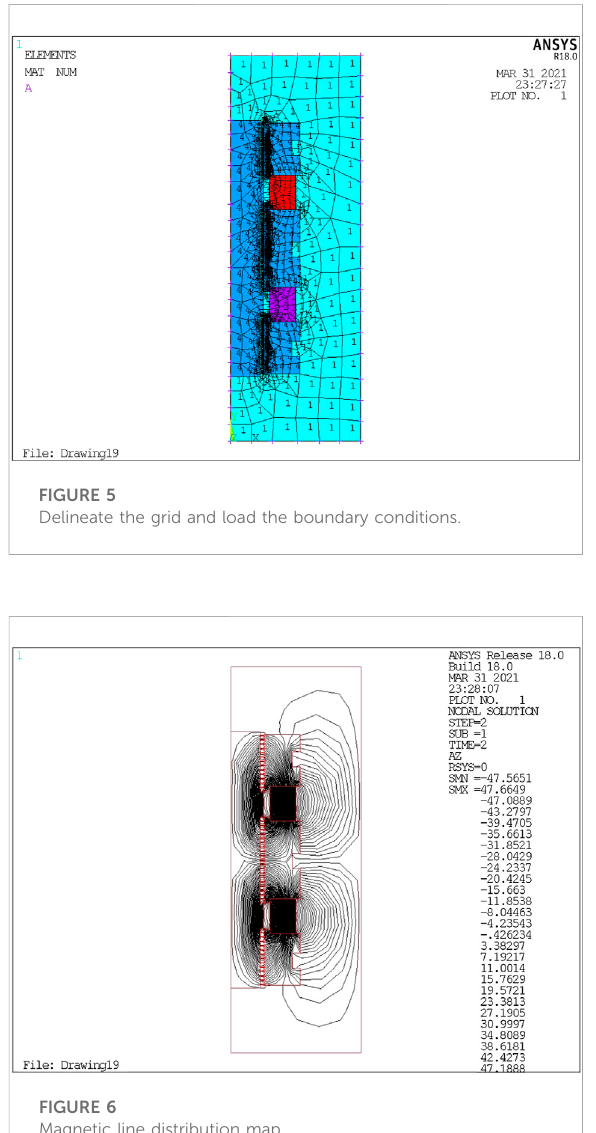
FIGURE 6 Magnetic line distribution map.